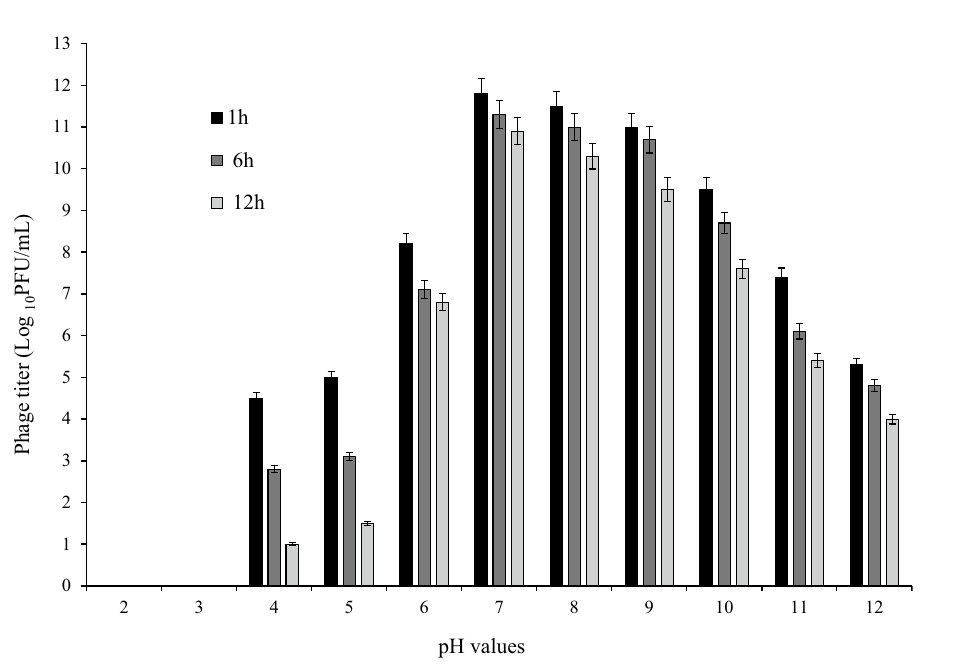
Figure 5. Stability of vB_EfaS-SRH2 phage at different pH values (2–12). The results are presented as the mean ± SD. Error bars indicate the standard